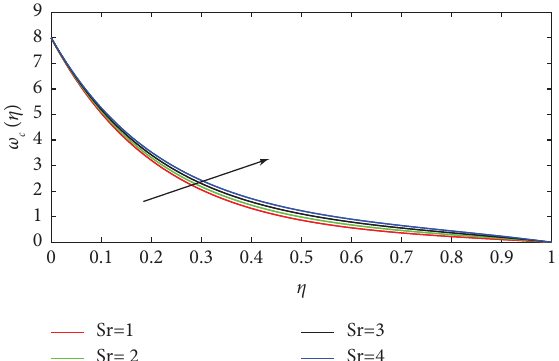
Figure 17: Concentration profles for the diferent values of Sr.